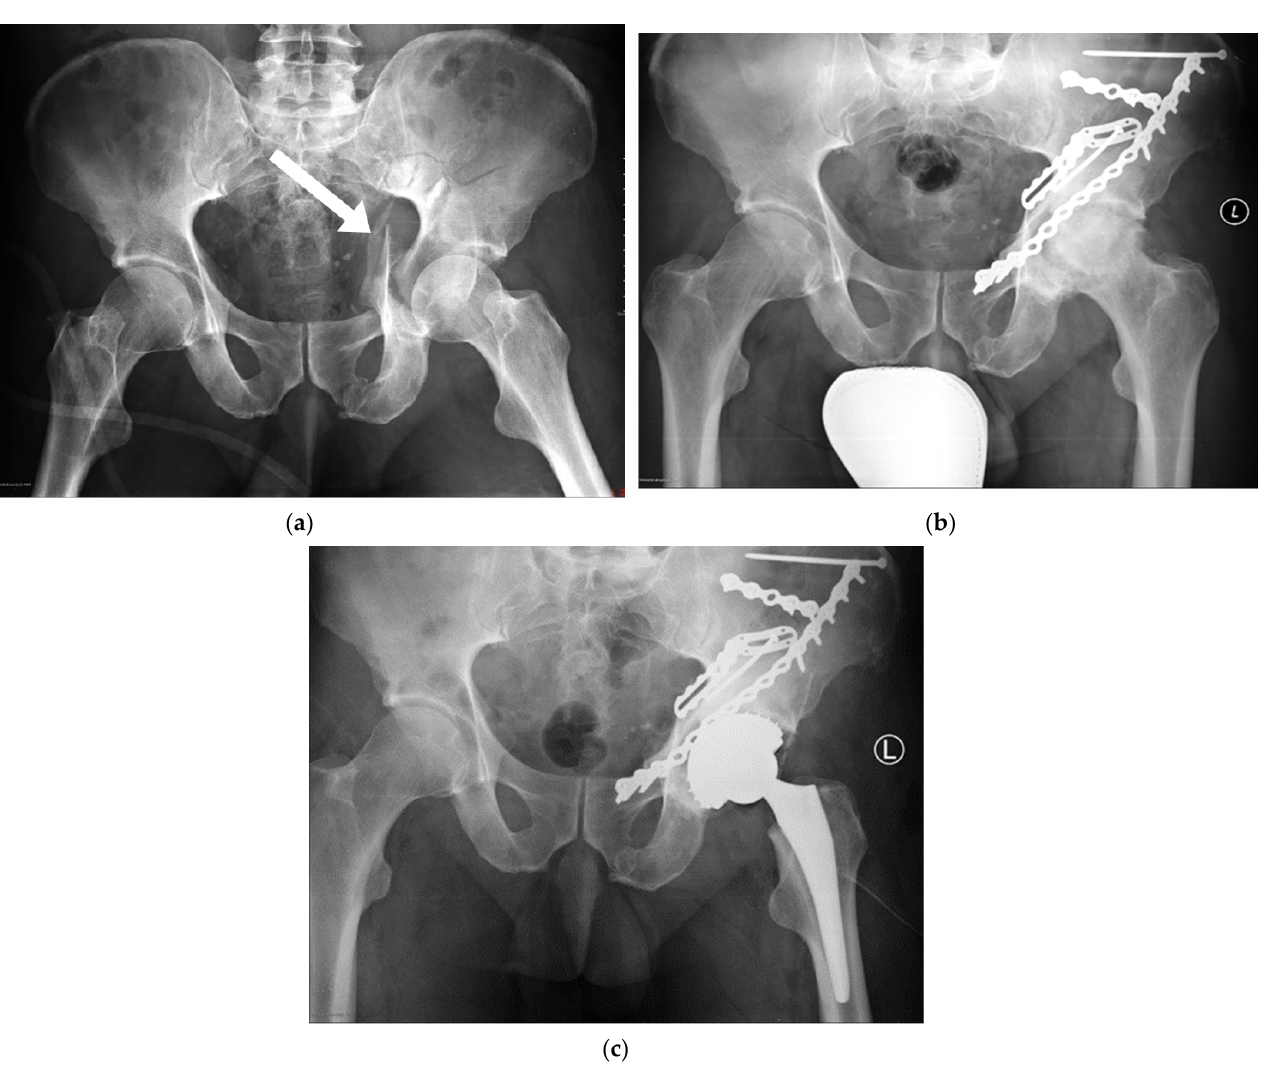
Figure 1. Degenerative changes progression (the arrow—the fracture fissure): ( a ) acetabular fracture (March 2012); ( b ) degenerative changes (April 2015); ( c ) hip arthroplasty (June 2015).